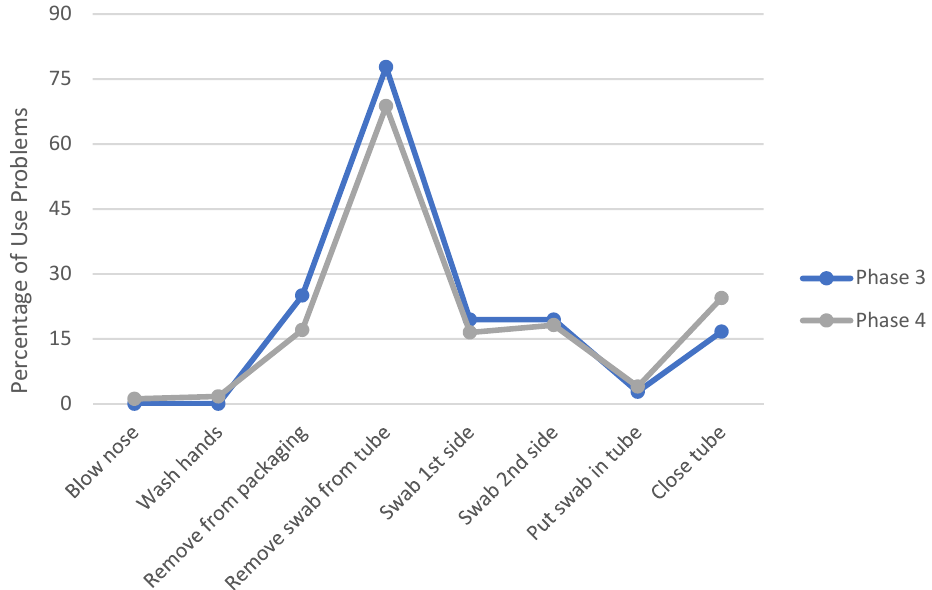
Figure 9. Comparison of observed use problems between XpressCollect and modified swab concept B in Phase 4.